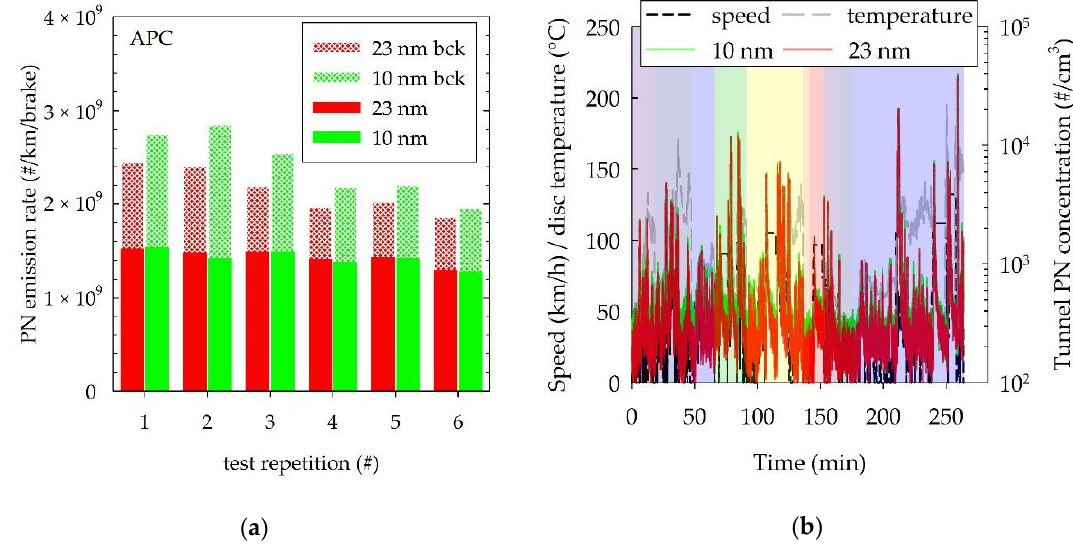
Figure 4. ( a ) Cycle average PN emission rates over 6 repetitions of the WLTP cycle for ECE#2 pads as determined with APC@10 and APC@23. The dashed sections of the bars illustrate the contribution of background; ( b ) example real time traces of the APC@10 and APC@23 (test #3).